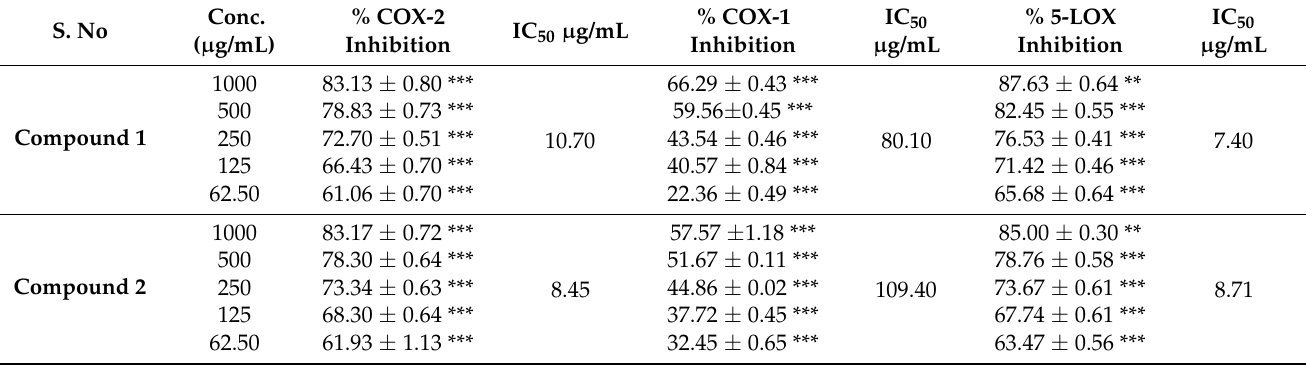
Table 2. Cyclo- and lipoxygenase inhibition results of the isolated phytosteroids from Fragaria ananassa